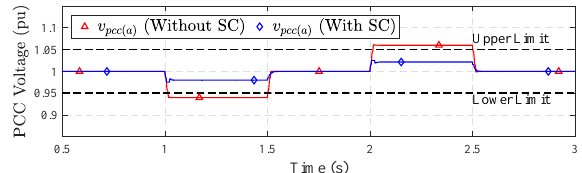
Figure 17. RMS PCC voltage profile with and without the smart charger.